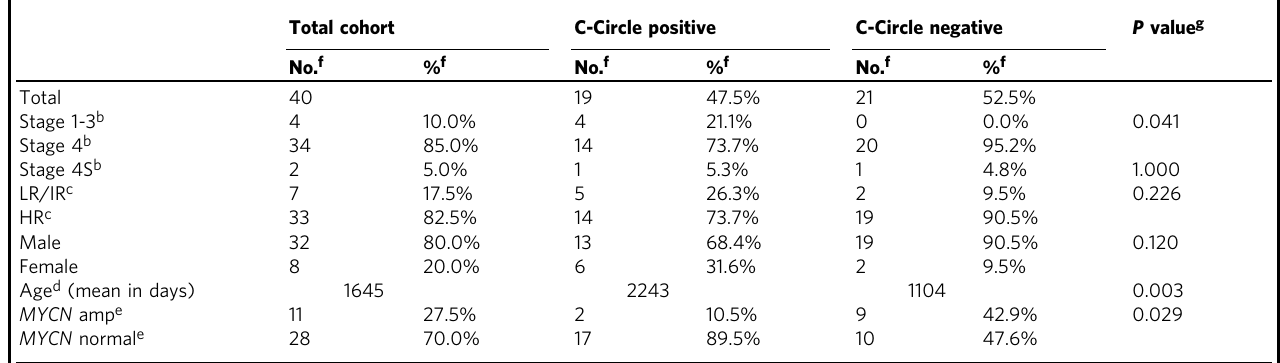
Table 2 Clinical features of C-Circle positive tumors in the INFORM cohort ( n = 40) a